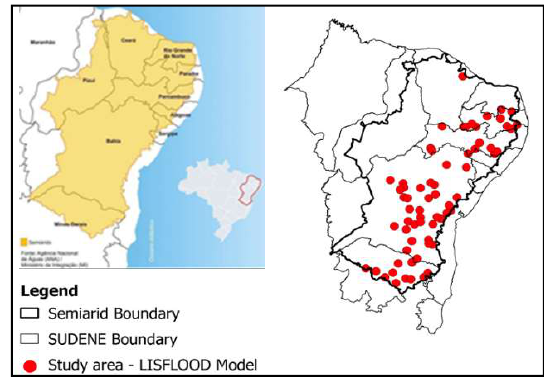
Figure 6. Map of Brazil showing the location of some of the CEMADEN in situ stations [16].